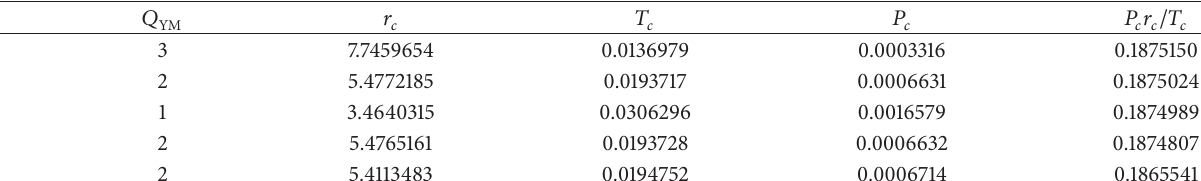
Table 1: Critical values for 𝑄 𝑒 = 1 .